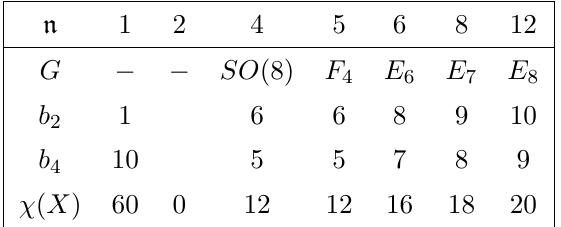
Table 23 . The normalised Euler characteristics of the non-compact elliptic Calabi-Yau threefolds associated to minimal 6d